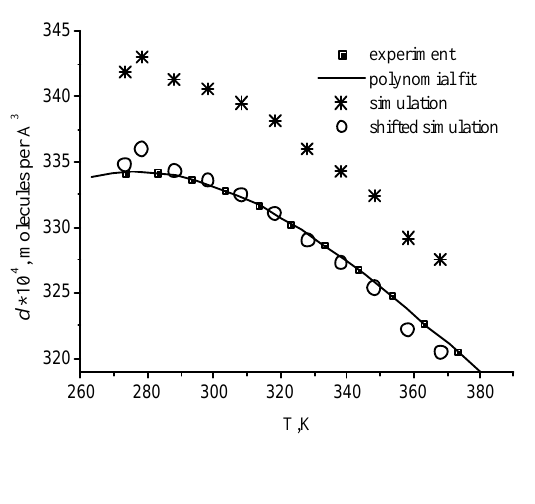
Figure 4. Temperature dependence of water number. The shifted simulation curve is shifted down by 0.0007 Å